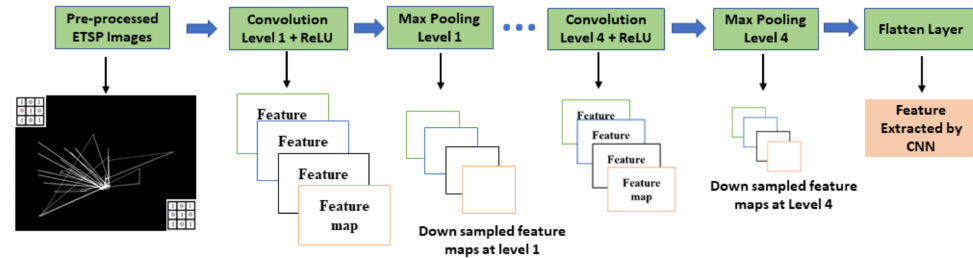
Figure 3. Structure of a four-layer CNN feature